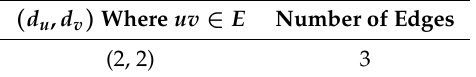
Table 5. Edge partition of G n ( n = 1 ) on the basis of degrees of end vertices of each edge. ( d u , d v ) Where uv E ∈